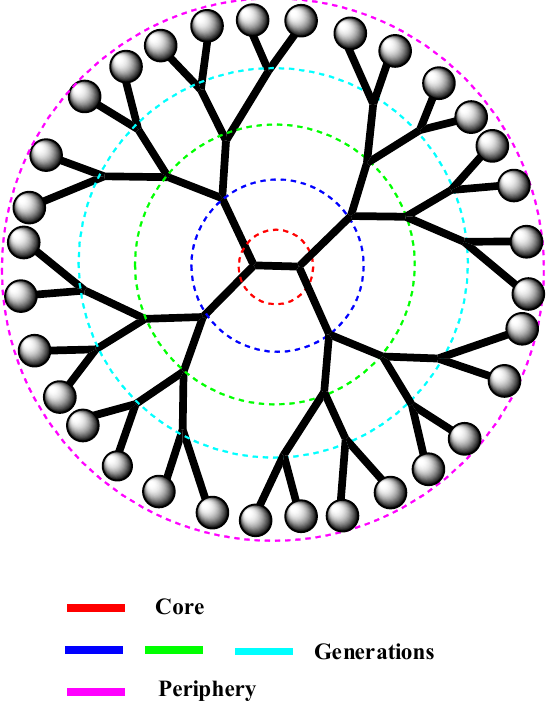
Figure 1. The architecture of a